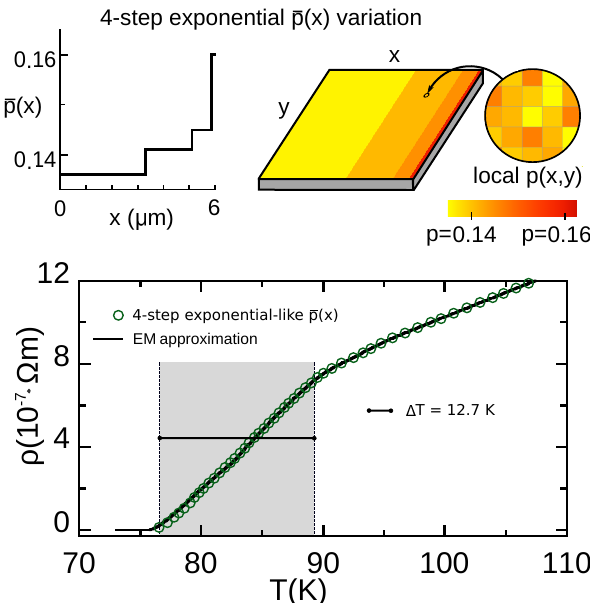
Figure 5. In the upper row, we illustrate a YBCO film patterned following the discretized four-step exponential-like variation of the nominal doping p ( x ) studied by us in Section 7. We also illustrate doping across the film as a 2D color map, taking into account that the local doping level p ( x , y ) (zoom in the picture) results from accumulating the four-step exponential p ( x ) and the random Gaussian disorder at smaller length scales of about (30 nm) 2 (see main text for details). In the lower row, we plot the resistivity vs. temperature ρ ( T ) that we obtain for such film (data points for finite-element computations, continuous line for analytical EM approximation, see Equation (25)). This is the most optimized design found in this work for the use in resistive HTS TES devices (see also Table